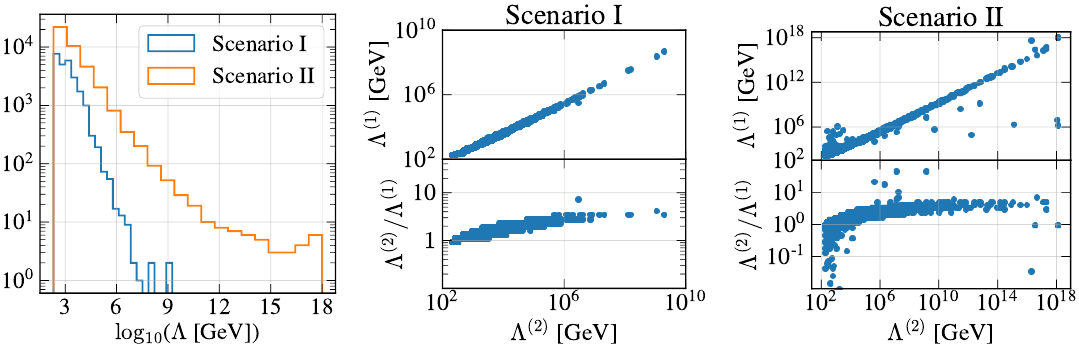
Figure 8 . (Left): histograms of breakdown energy, (cid:3), in the parameter scans of scenario I & II. Breaking the Z 2 softly opens up a parameter region where models are valid all the way up to the Planck scale. (Middle & Right): comparison of breakdown energy scales using 1-loop and 2-loop RGEs in scenario I & II respectively. We de(cid:12)ne (cid:3) ( n ) as the energy scale where either perturbativity, unitarity or stability is violated using the n -loop RGEs.